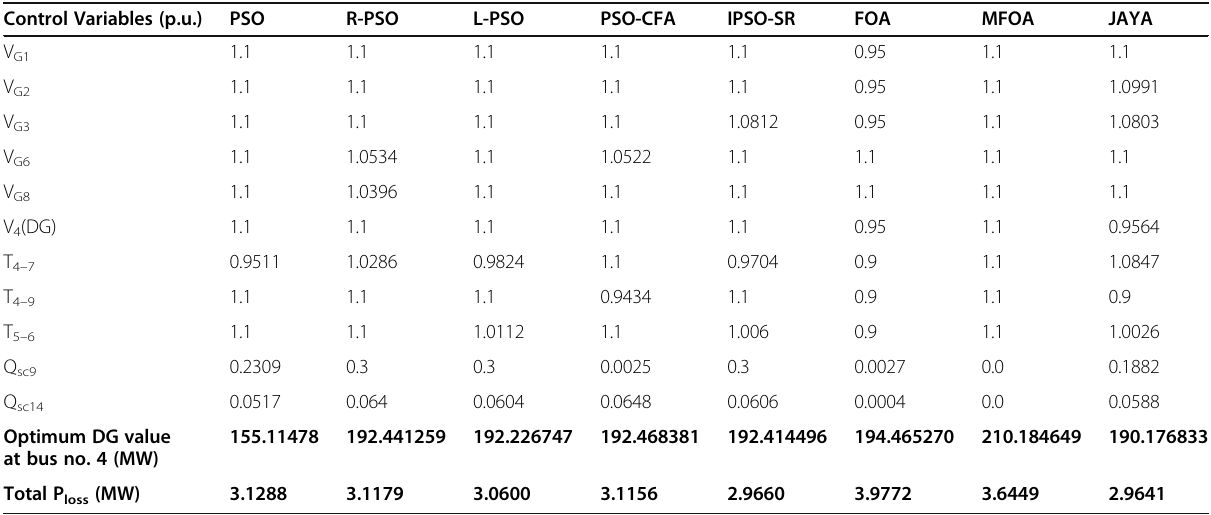
Table 13 Simulation results on IEEE 14 bus system with DG using different algorithms Control Variables